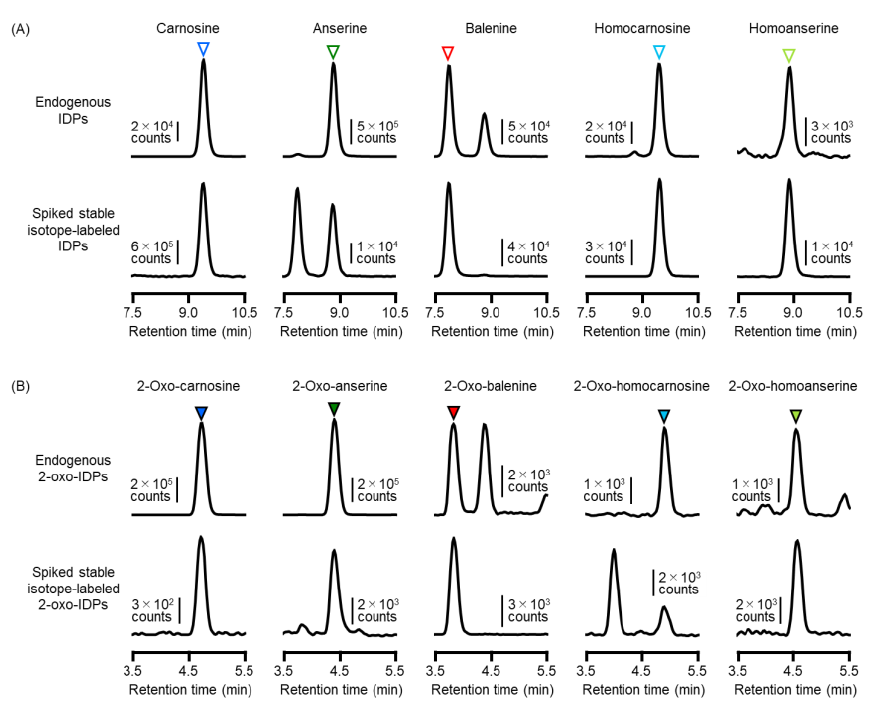
Figure 5. HPLC-ESI-MS/MS analysis of IDPs and 2-oxo-IDPs in beef. Meat samples were homogenized in 80% acetonitrile/water containing stable isotope-labeled standards, and extracted IDPs and 2-oxo-IDPs were subjected to HPLC-ESI-MS/MS analysis. ( A ) Representative chromatograms of endogenous IDPs (upper trace), and spiked isotope-labeled IDPs (lower trace) are shown. Open triangles indicate each IDP. ( B ) Representative chromatograms of endogenous 2-oxo-IDPs (upper trace), and spiked isotope-labeled 2-oxo-IDPs (lower trace) are shown. Filled triangles indicate each 2-oxo-IDP. Table 4. Quantitative HPLC-ESI-MS/MS analysis of IDPs and 2-oxo-IDPs in meat samples. IDPs (nmol/mg